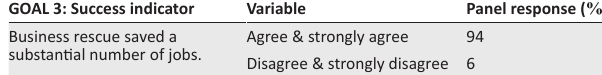
TABLE 6: Business rescue success criteria for Goal 3 (employees’ job opportunities should be protected). GOAL 3: Success